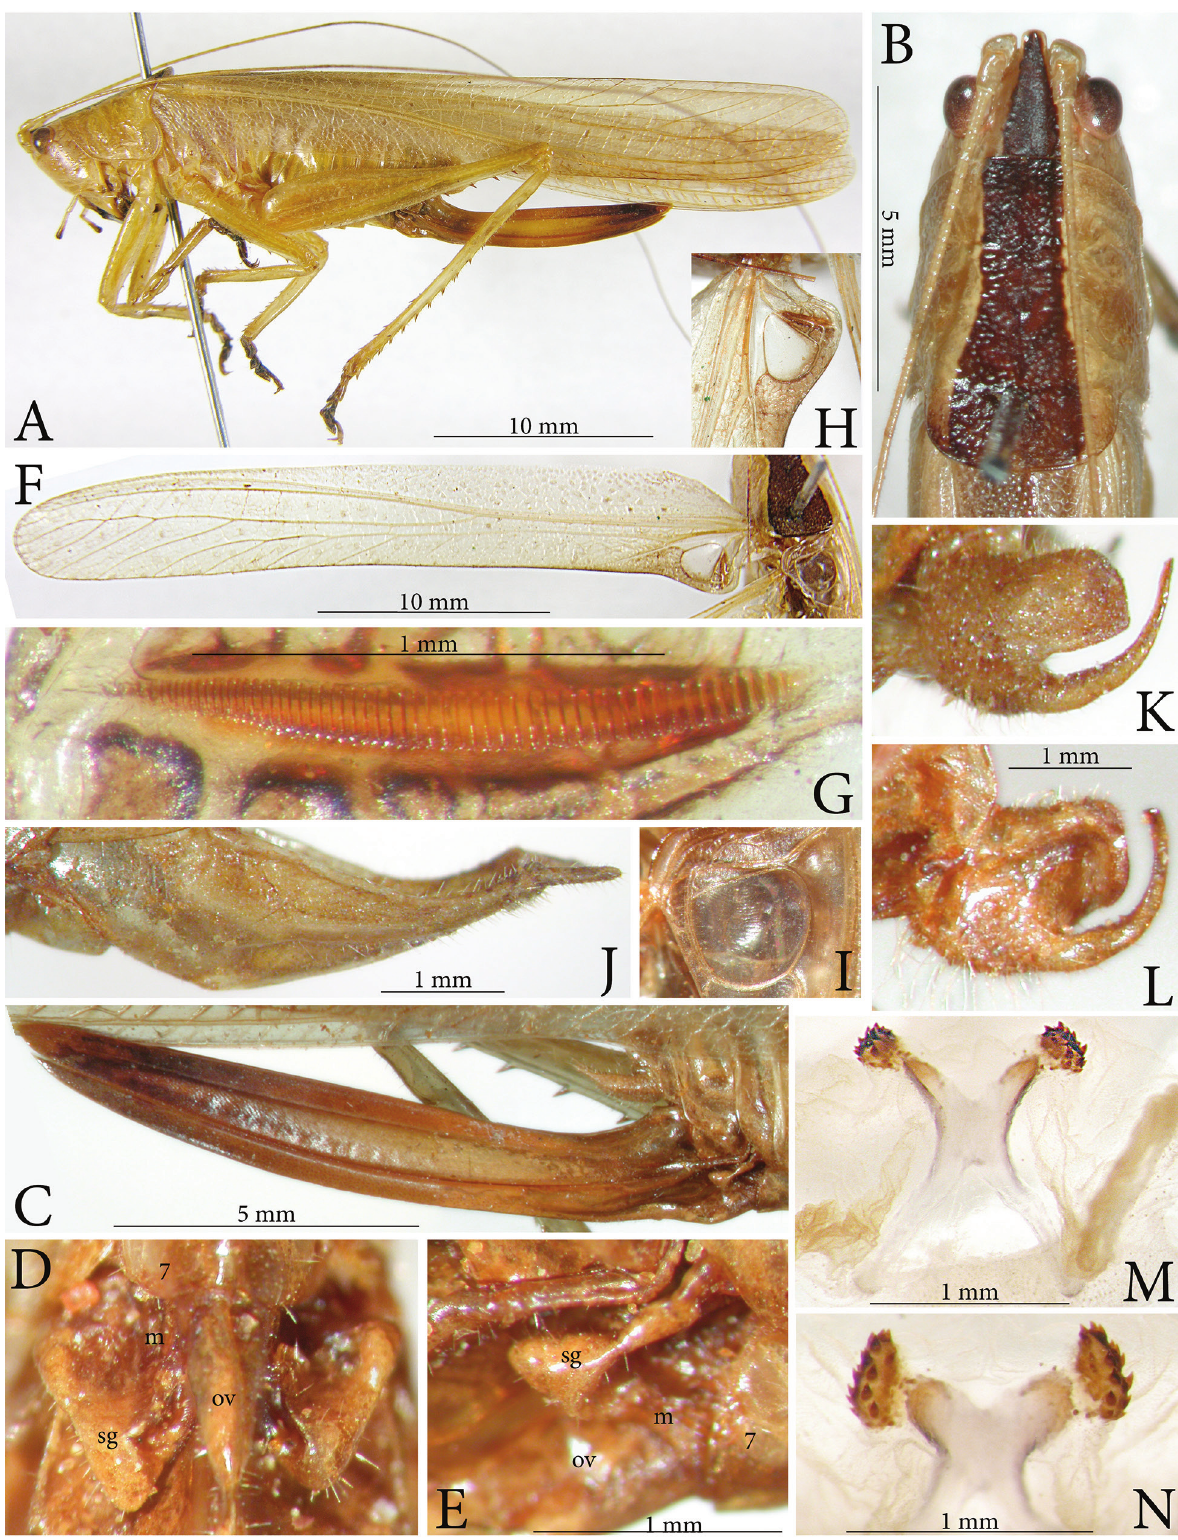
Figure 6. Pseudosubria assamensis sp. nov. A–E female: A habitus lateral view; B head and pronotum; C ovipositor; D, E subgeni- tal plate in ventral ( D ) and lateral view ( E ). – F–N male holotype: F left tegmen; G stridulatory file; H base of left tegmen; I mirror of right tegmen; J subgenital plate in lateral view; K, L cercus in external ( K ) and internal ( L ) view; M, N phallus with titillators. Abbeviations: 7 seventh sternite, m membrane, ov base of ovipositor, sg lateral lobes of subgenital